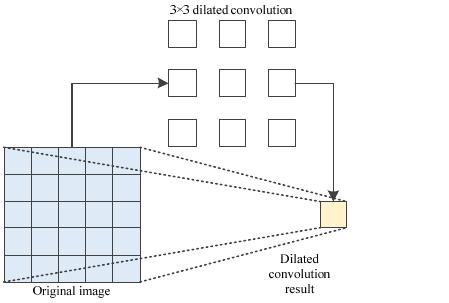
Figure 6. Process of 3 × 3 ordinary convolution twice.